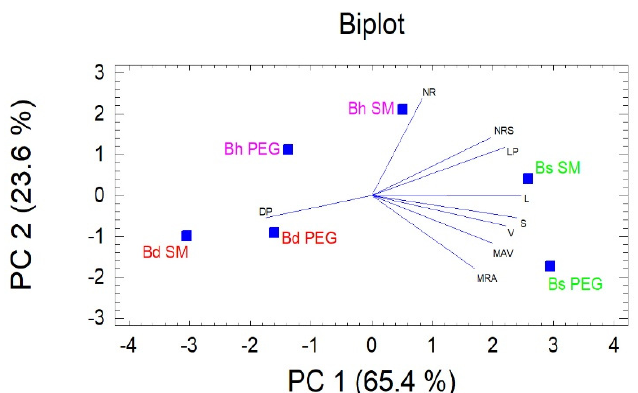
Figure 2. Biplot of the two first principal components, showing trait vectors of the root system architecture (RSA), and the location of the Brachypodium ssp. in both culture media. DP: mean diameter of the seminal roots, L: total root length, MAV: the minimum seminal root angle with respect to the vertical, MRA: mean of all seminal root angles with respect to the vertical, NR: number of seminal roots, NRS: number of secondary roots, PL: primary root length, S: total surface area of the roots, V: total roots volume